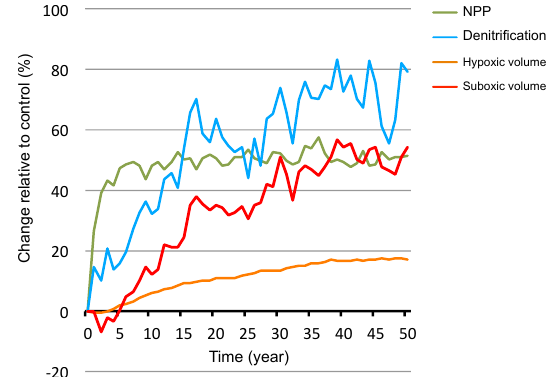
Figure 6. Response to monsoon wind increase as a function of time. Response to wind stress increase ( + 50%) of NPP, denitrification and suboxic and hypoxic volumes as a function of